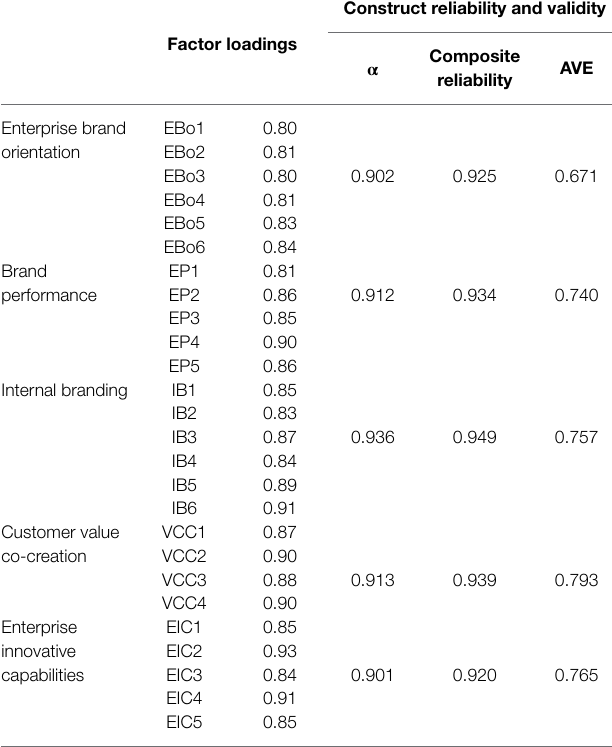
TABLE 6 | Model assessment